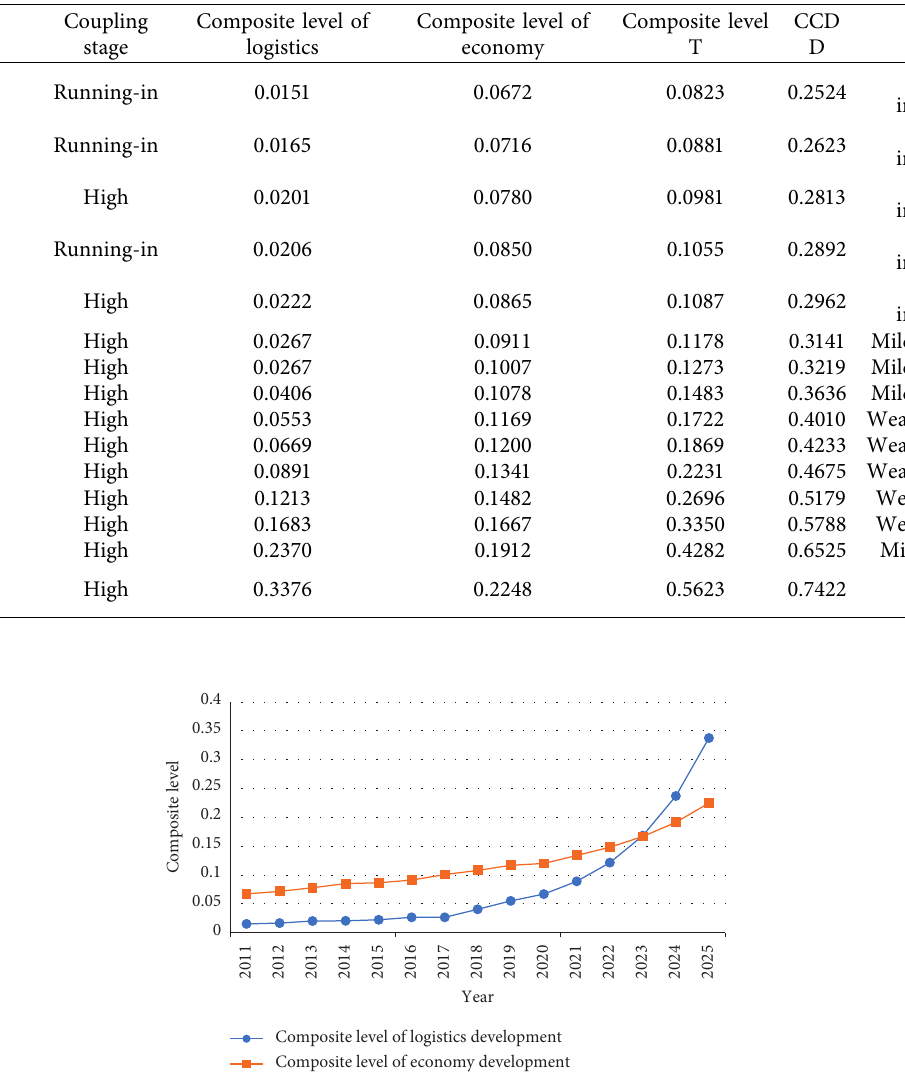
Figure 1: Composite levels of economic and logistics development.